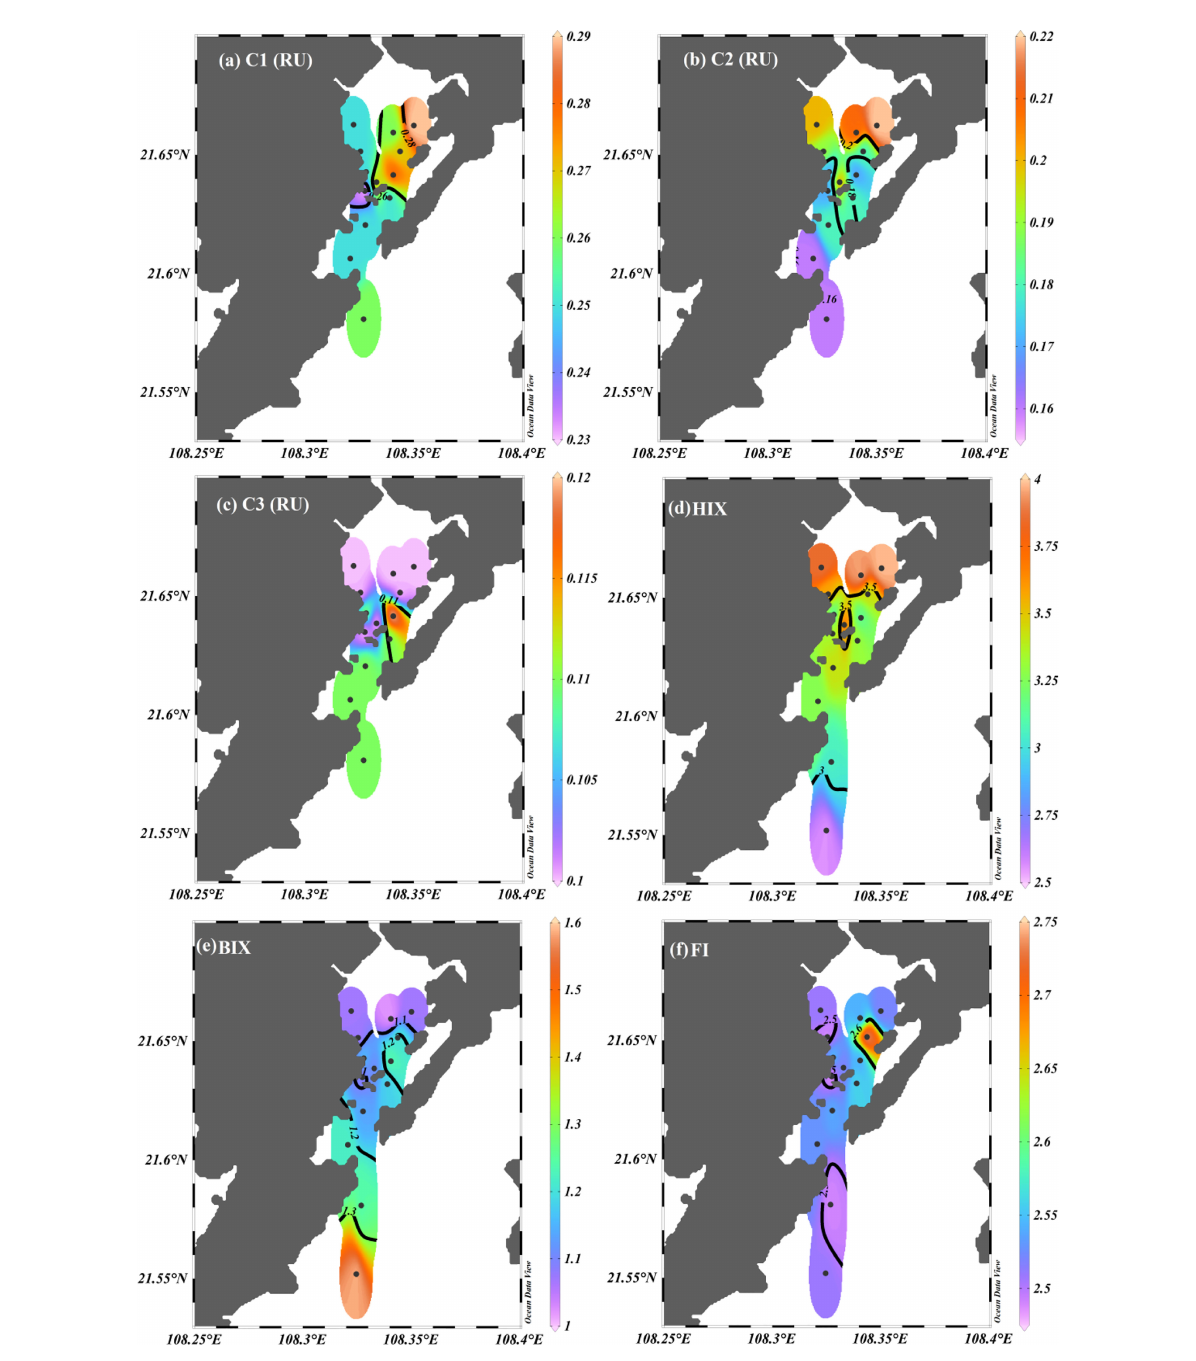
FIGURE 5 Spatial distributions of (A) C1 (RU), (B) C2 (RU), (C) C3 (RU), (D) HIX, (E) BIX, and (F) FI in Xi Bay. Black dots represent the sampling